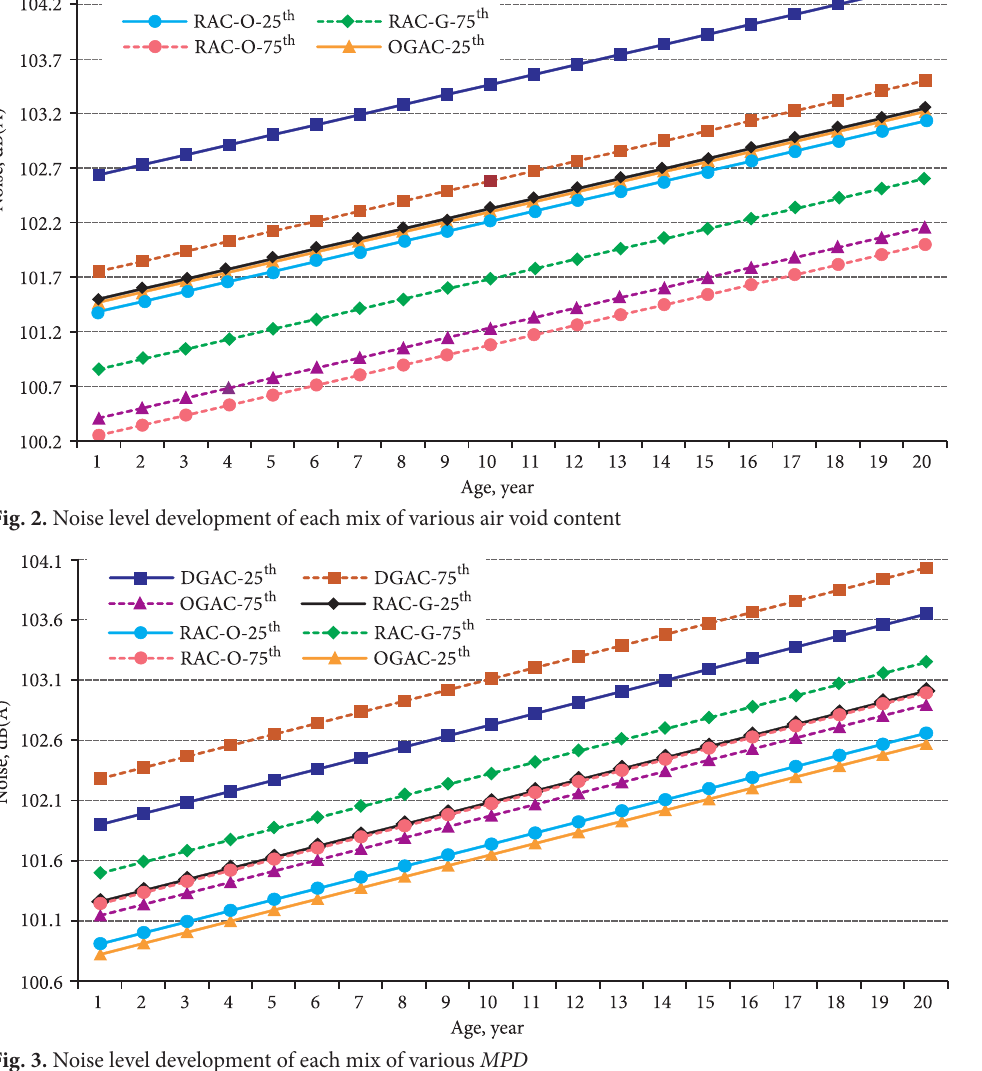
Fig. 3. Noise level development of each mix of various